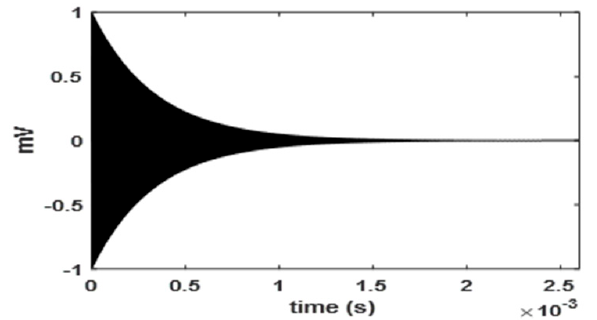
Figure A1. Decaying sinusoidal waveform.